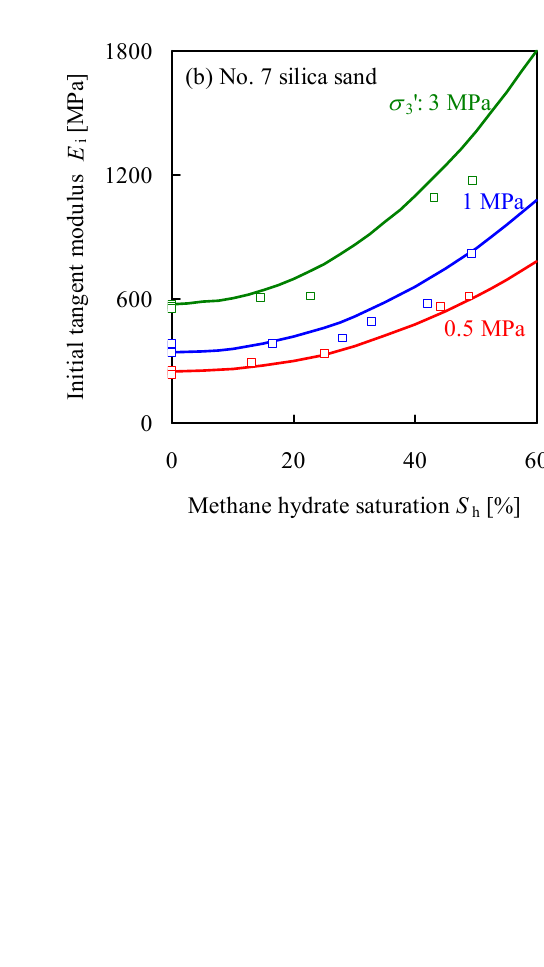
versus methane hydrate saturation S i